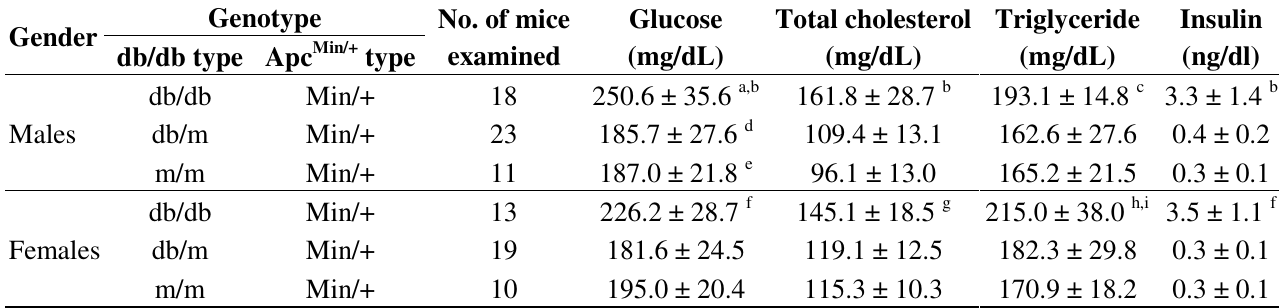
Table 2. Serum levels of glucose, total cholesterol, triglyceride, and insulin of mice at 15 weeks of